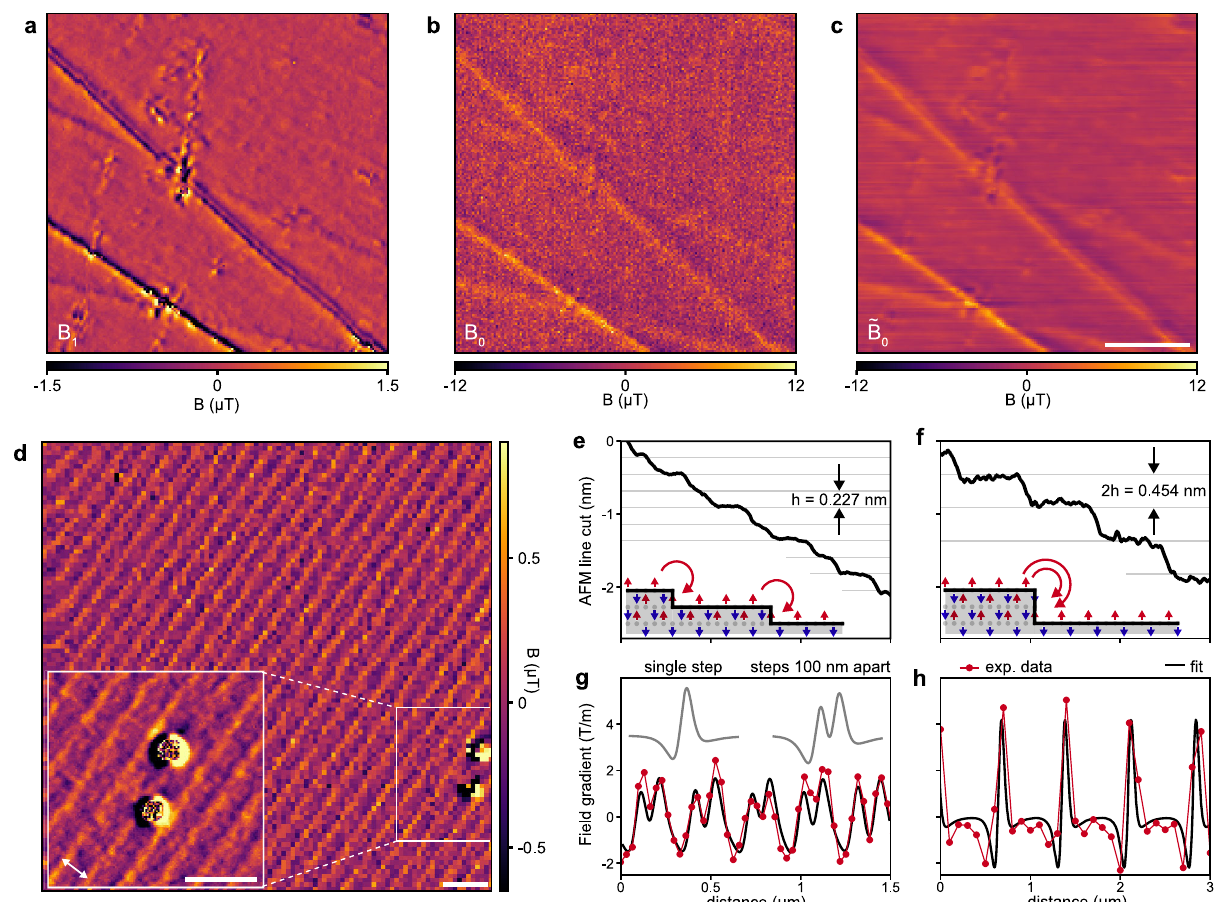
Fig. 4 Topographic fi elds from antiferromagnetic Cr 2 O 3 . a Gradiometry map B 1 of topographic defects from a polished Cr 2 O 3 single crystal. Dwell time is 10 s per pixel and x osc = 23 nm. b Corresponding static fi eld map B 0 . Dwell time is 1 s per pixel. c Improved static fi eld map ~ B 0 obtained from a weighted average of a and b (see Methods). The noise standard deviation is reduced from 1.8 μ T ( b ) to 90 nT in the oscillation direction ( x -direction) and 340 nT in the y -direction ( c ). The directional sensitivity could be avoided using tapping mode oscillation (see Methods). When normalized by measurement time, B 1 is more sensitive than B 0 by a factor larger than 8. d B 1 image of the stray fi eld generated by atomic steps on an as-grown Cr 2 O 3 (0001) surface. Two magnetic defects which produce much larger gradient signals are also visible. Inset is a detail of defects and atomic steps recorded with higher pixel resolution. The distance between steps is ca. 400 nm (arrow). Dwell time is 5 s per pixel. Scale bars in a – d 1 μ m. e , f AFM line scans revealing mono- and diatomic steps with different terrace sizes. h is the distance between neighboring O-planes along the Cr 2 O 3 c -axis 53,54 . Insets show sketches of atomic steps and up – down ordering of Cr 3 + moments (red, blue). Curved arrows are fi eld lines. g – h Gradiometry line scans acquired over different areas on the as-grown Cr 2 O 3 surface. The pro fi les are fi tted to a stray fi eld model involving atomic steps (solid lines). x osc = 46 nm in d , g , and h